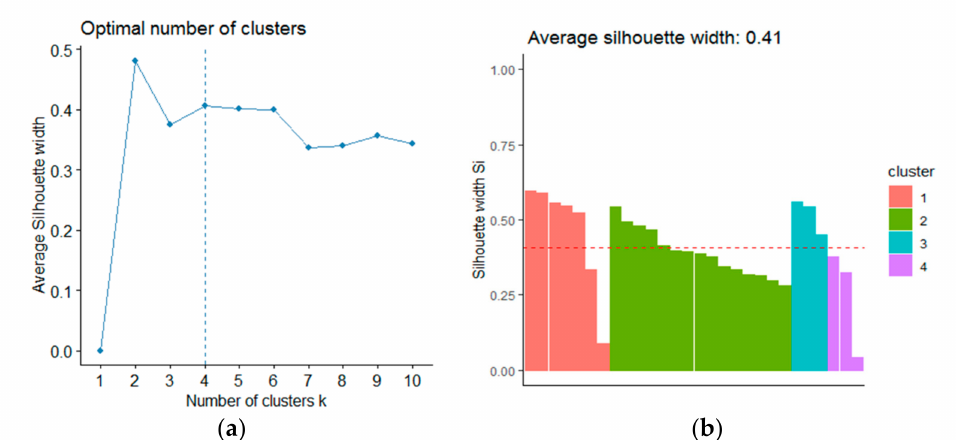
Figure 15. ( a ) The average silhouette index for different numbers of clusters, ( b ) value of silhouette index for each country in DIANA clustering. Source: own preparation.